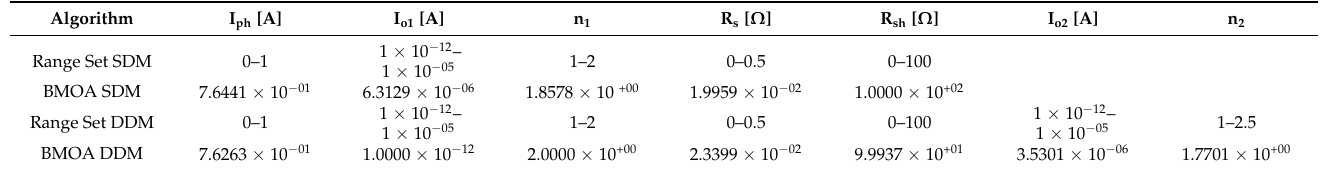
Table 9. RTC silicon photovoltaic cell parameters and